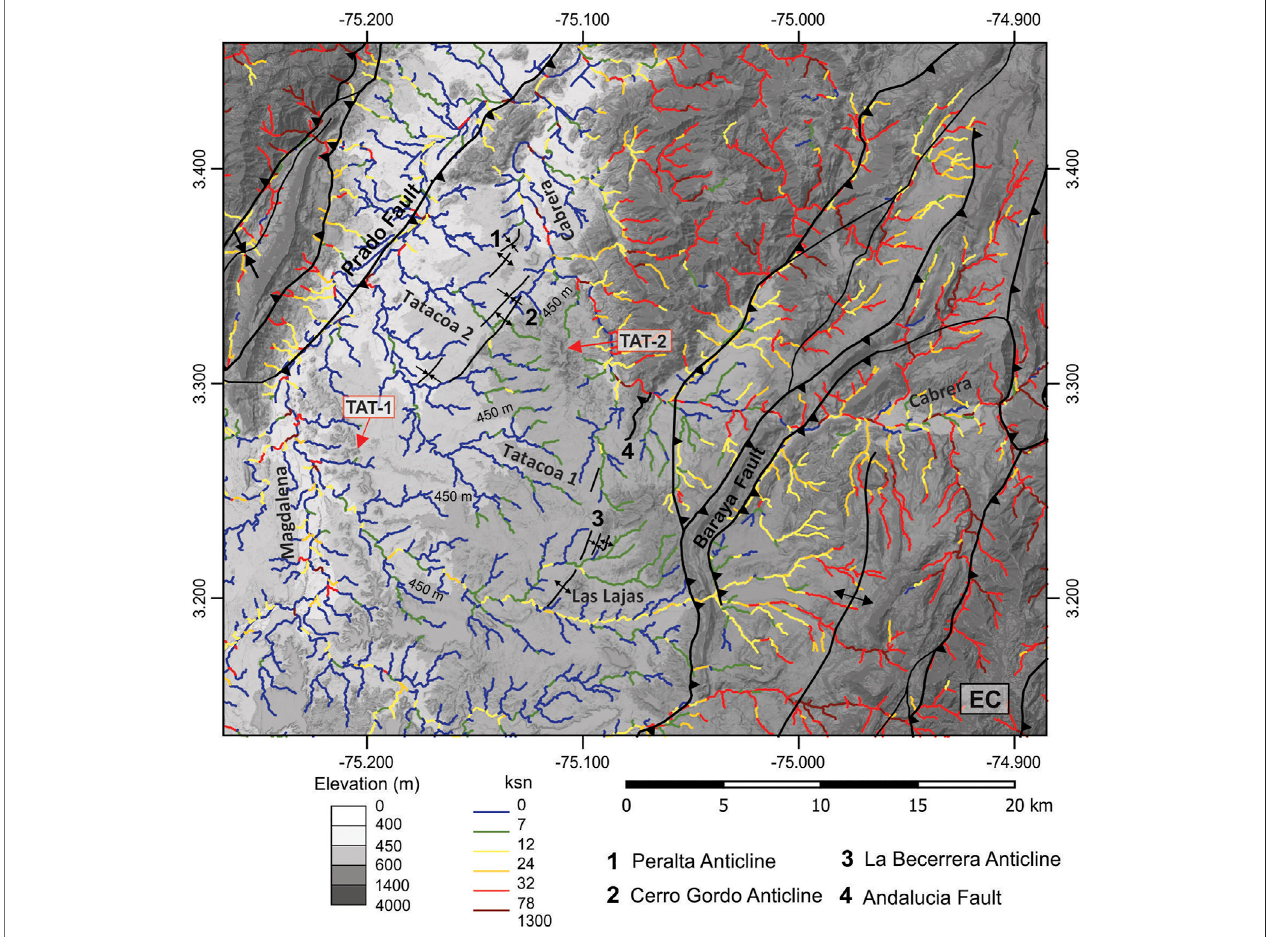
FIGURE 7 | Ksn map TanDEM-X hypsometric map. TD is the Tatacoa Desert and EC is the Eastern Cordillera. The height of 450 m is highlighted by labels. This heightispunctuatedbyasubtleincrease inksn(knickpoints) andoutlinesthe upstream propagation ofincision after theMagdalenaterraces (e.g. TAT-1)abandonment. It is noted that in Tatacoa 2 catchment the incision advance is stopped at Cerro Gordo Anticline.